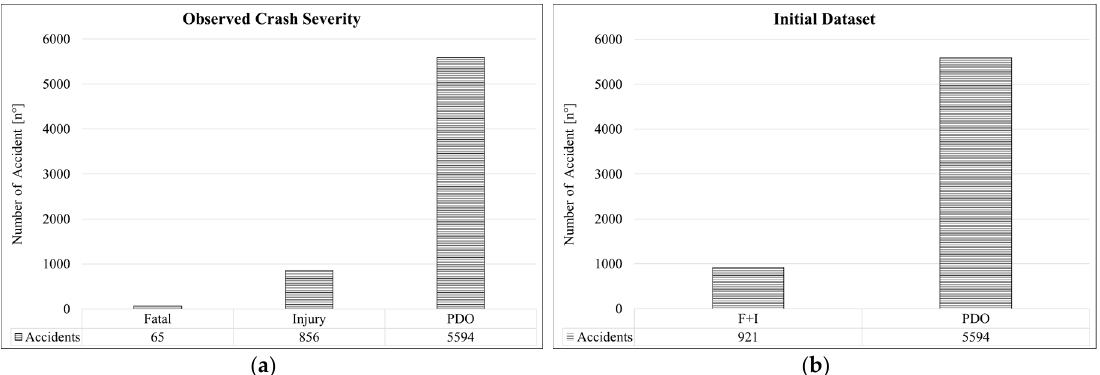
Figure 3. Severity classes: ( a ) observed crash severity and ( b ) initial dataset.